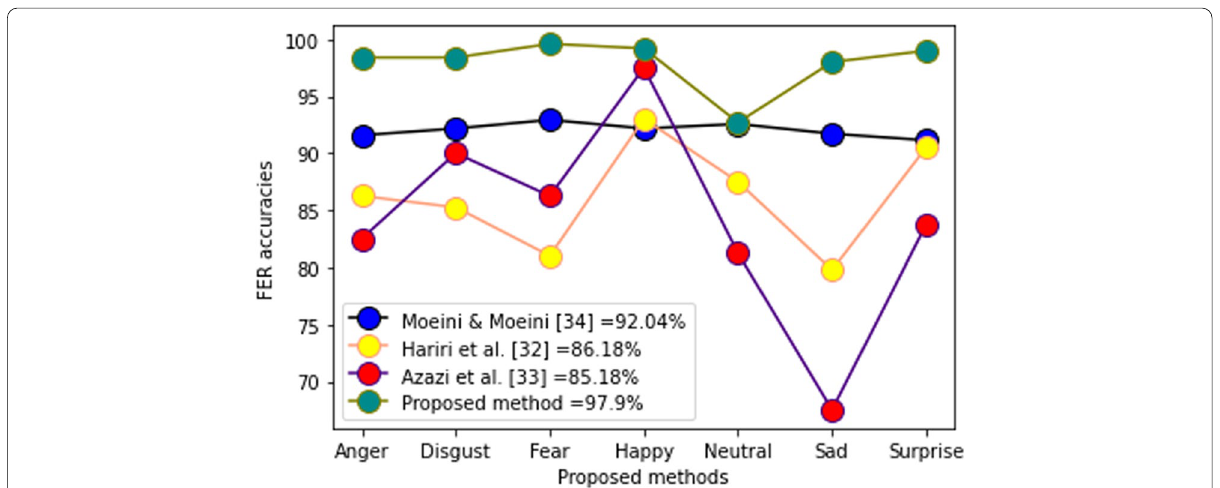
Fig. 19 Performance of 7 FER prototypes in Bosphorus